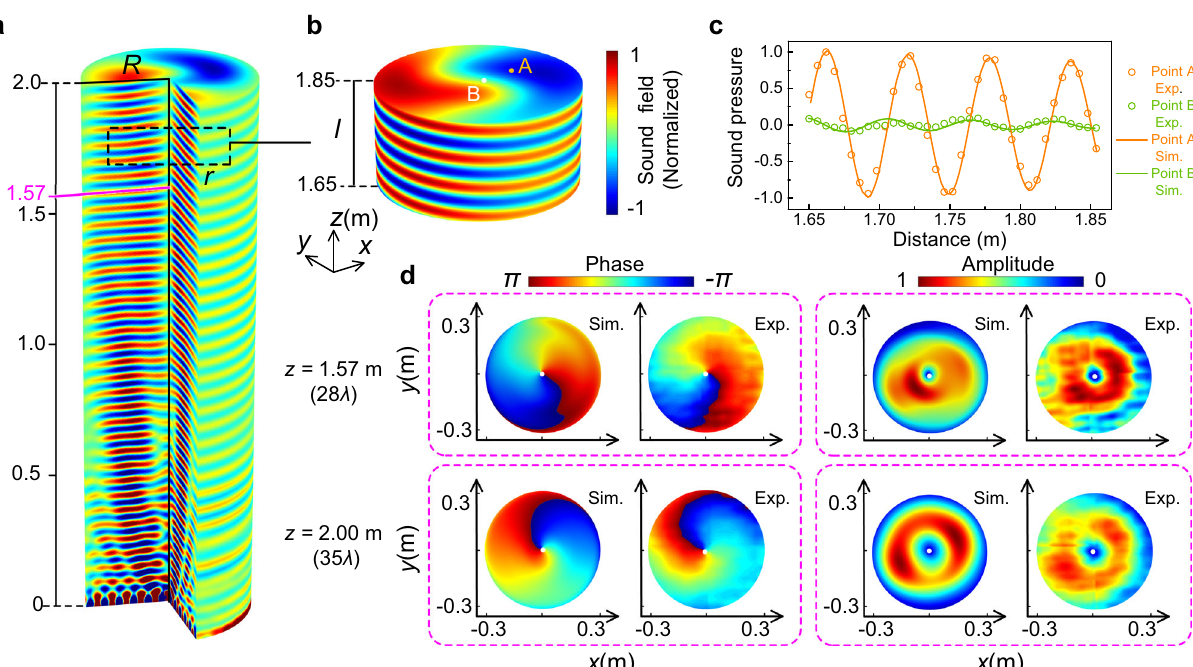
Fig. 4 Far- fi eld spiral sound in free space. a Normalized sound pressure fi eld along the propagation axis in cutaway view. The cutting position is the cylinder with the radius R = 0.3 m. The transition point between the near and far fi eld is around 1.57 m. b Zoom-in of the far- fi eld rotating wavefront, which is taken from a region with radius r = 0.2 m and l = 0.2 m, located at z 0 = 1.65 m (black dashed line in a ). c Experimentally measured (Exp.) and simulated (Sim.) sound pressure pro fi les along the vertical lines across point A and B in b . d Experimentally measured and simulated phase and amplitude distribution of the helical wavefront at two observation planes located at 1.57 and 2.00 m away from the metasurface, respectively. The white dots refer to the geometric centers of the phase cross-sections.